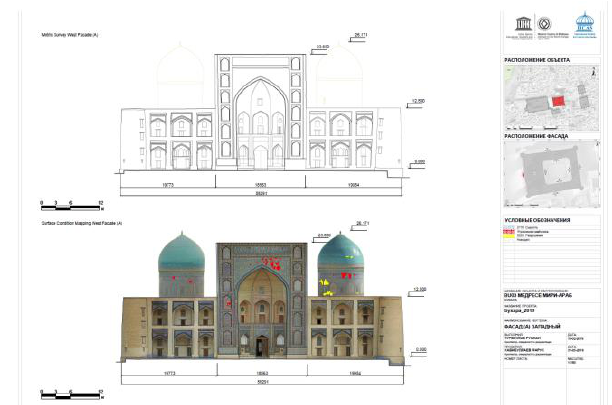
Figure 11 . Drawing and orthophoto mapping damages of north Façade of Miri-Arab Madrassah. Source: authors.